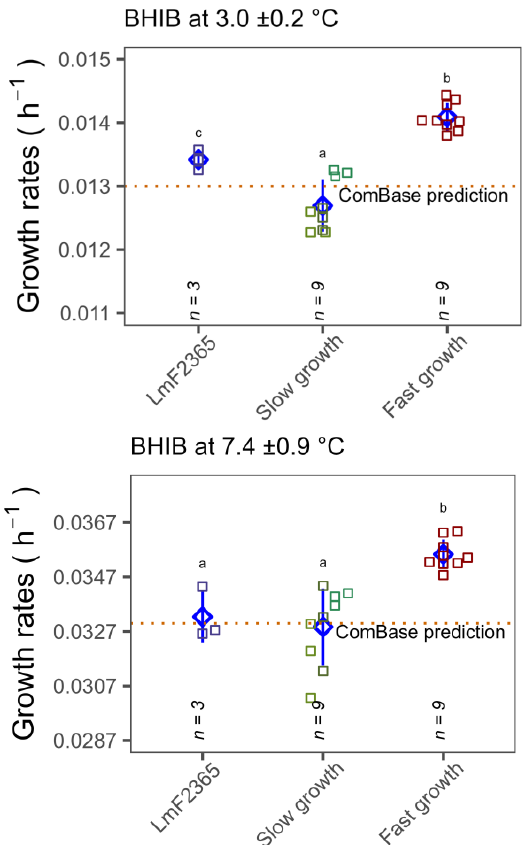
Figure 5. Comparison of the growth rates of seven selected isolates (slower growing in green Lm1372, Lm1378 and Lm1991 (CC3, CC5 and CC121, respectively) and faster growing in red Lm1515, Lm3443, Lm3448 (CC18)) and reference strain in light blue, LmF2365 (CC1), at 3 ± 0.2 and 7.4 ± 0.9 ◦ C in BHIB. Error bars (pointrange in blue) represent standard deviations of three independent assays for each isolate. Different lower case letters indicate significant differences at p < 0.05. Since it has been shown that food microstructure can have a major impact on micro- bial growth kinetics [27], it was decided to perform further growth rate studies with one selected isolate from each group (fast growth and slow growth) in three real food matrices. Risk- and evidence-based screening were performed in the Rapid Alert System for Food and Feed (RASFF) food notification tool regarding L. monocytogenes contamination in food for human consumption between September 2020-March 2022 in the EU. From the result- ant data, it was determined that fish and fish products and dairy products were impacted most by L. monocytogenes contamination (Supplementary Figure S1). Therefore, growth data in milk, chocolate milk and a fish pie product was generated (Figure 6). Growth of the strains in the UHT milk and fish pie was similar to the growth observed in BHIB in that isolate Lm3443 (the fast growth CC18 representative) grew the fastest and isolate Lm1991 (the slow growth CC121 representative) grew slower. A similar trend was ob- served in the chocolate milk but the differences were not statistically significant. It was also noted that all CC1 and CC18 isolates grew better in the fish pie than in the dairy products.